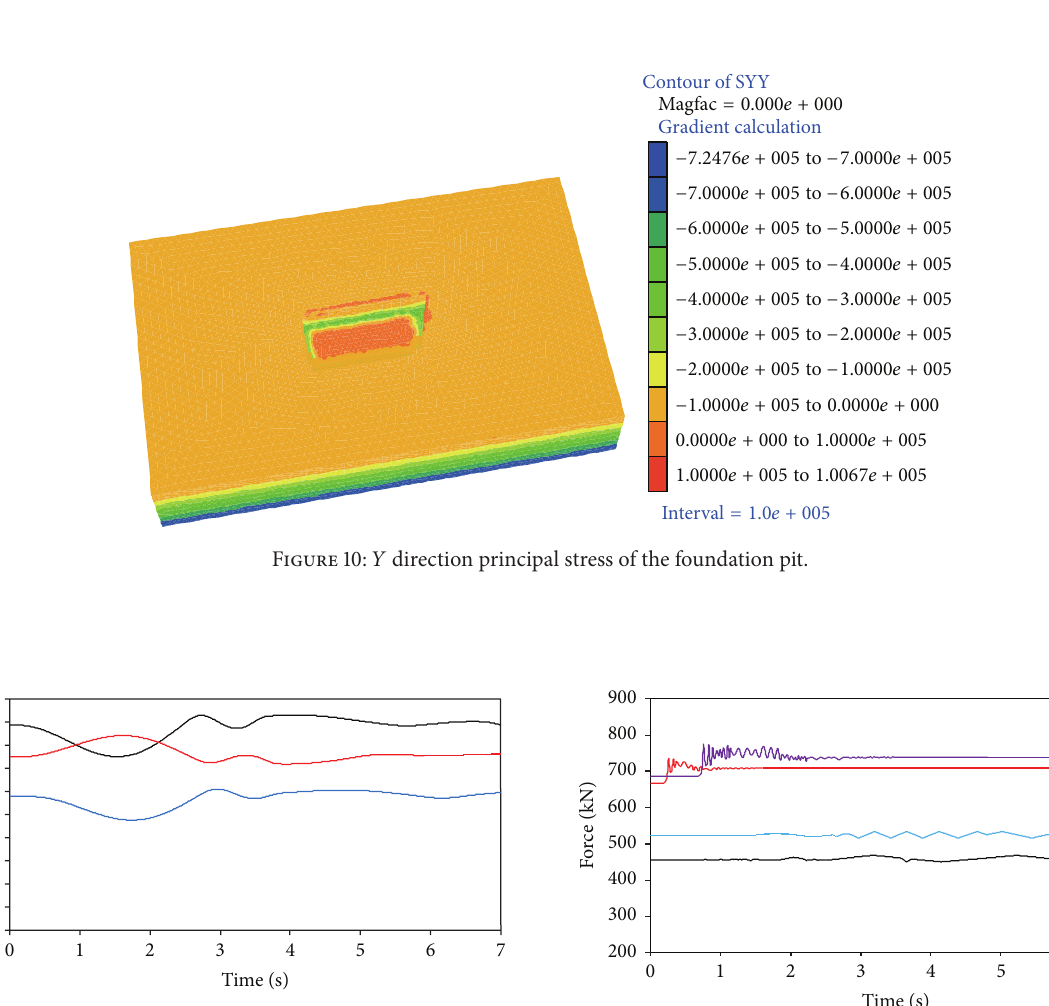
Figure 9: 𝑋 direction principal stress of the foundation pit.